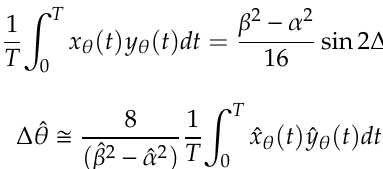
Figure 10. Reference frame of translational motion